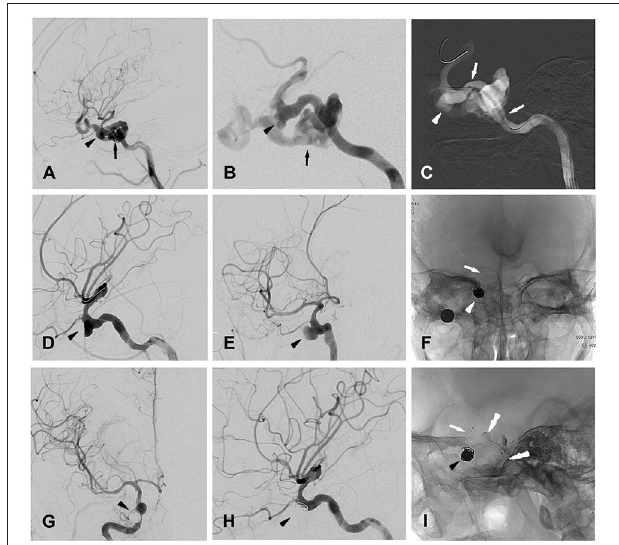
FIGURE 1 | Patient 5 (A,B) (magnified), lateral (A) and oblique (B) views of right ICA angiogram showing the traumatic carotid-cavernous fistula (CCF, indicated by black arrow) as well as one pseudoaneurysm (indicated by black arrow head) located at cavernous segment of ICA. (C) Intra-procedural road map during stent graft (white arrows) positioning for occluding the CCF, with white arrow head indicating the pseudoaneurysm. (D,E) Oblique views of right ICA angiogram showing the complete occlusion of the CCF and the remained pseudoaneurysm (indicated by black arrow head). (F) Post-treatment radioscopic anteroposterior view of the placed coils (white arrow head) and stent (white arrow) for the stent-assisted coiling procedures. (G,H) Anteroposterior (G) and lateral (H) views of a right ICA angiogram showing the completely occluded traumatic pseudoaneurysm (black arrow head). (I) post-treatment radioscopic lateral view of the placed coils (black arrow head) and the stent (white arrow) for stent-assisted coiling, as well as the covered- stent (black double-arrow heads) for treating